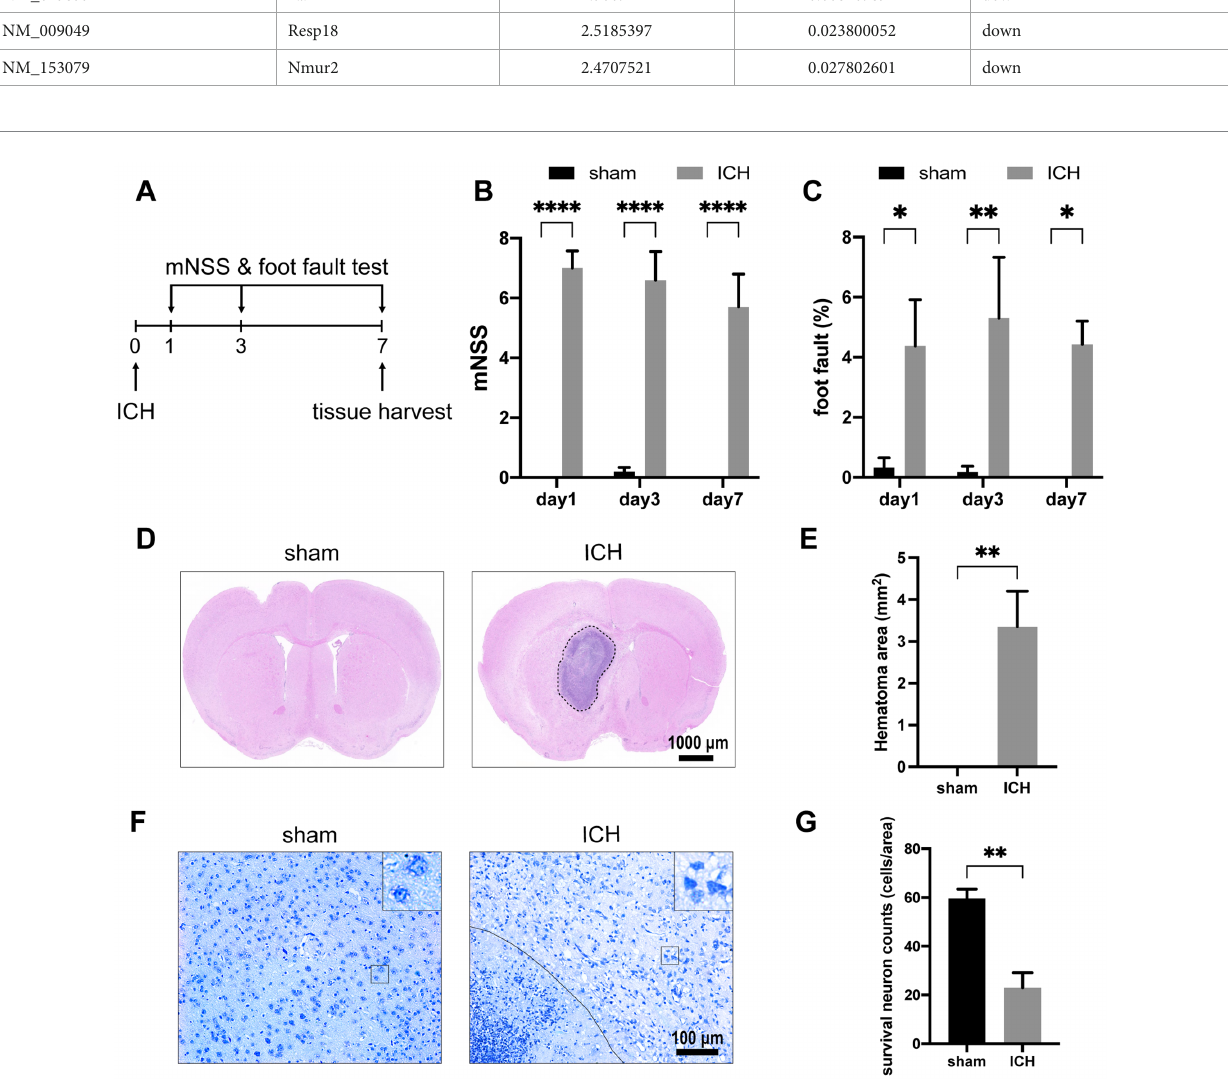
FIGURE 2 ICH-induced neurological deficits and histology alterations. (A) Schedule of behavioral tests and tissue harvest. The mNSS (B) and foot-fault test (C) were measured for the two groups at three time points (day 1, day 3, day 7) post-ICH. ( n = 7–10 mice in each group) Representative H&E staining (D) and Nissl staining (F) images on day 7 post-ICH. (E) Compared with the sham group, the ICH group exists significant hematoma. ( n = 5 mice for each group) (G) The number of survival neurons in the ICH group was significantly decreased compared with that in the sham group. ( n = 4 mice for each group) Data are presented as mean ± SEM, * p <0.05, ** p <0.01, **** p